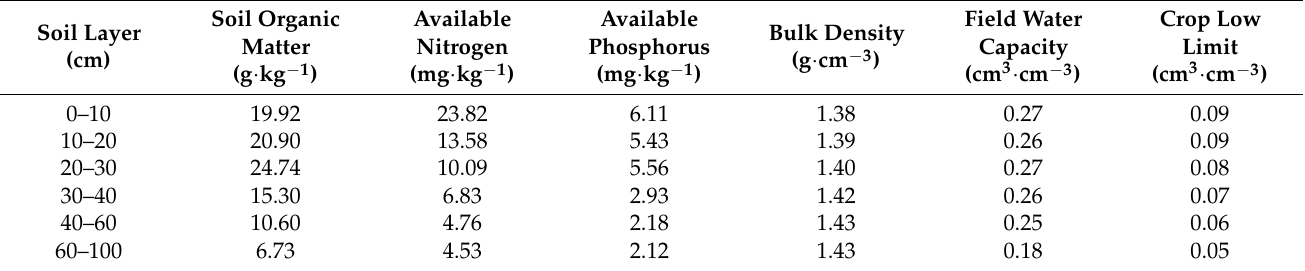
Table 1. Soil organic matter, soil available N, bulk density, the field capacity, and crop low water limit in the 0–100 cm soil layer measured at the beginning of the